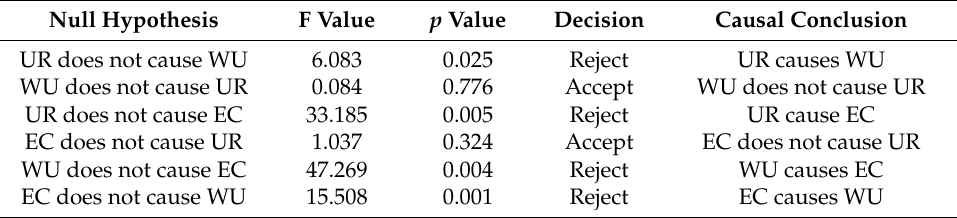
Table 2. Results of Granger causality